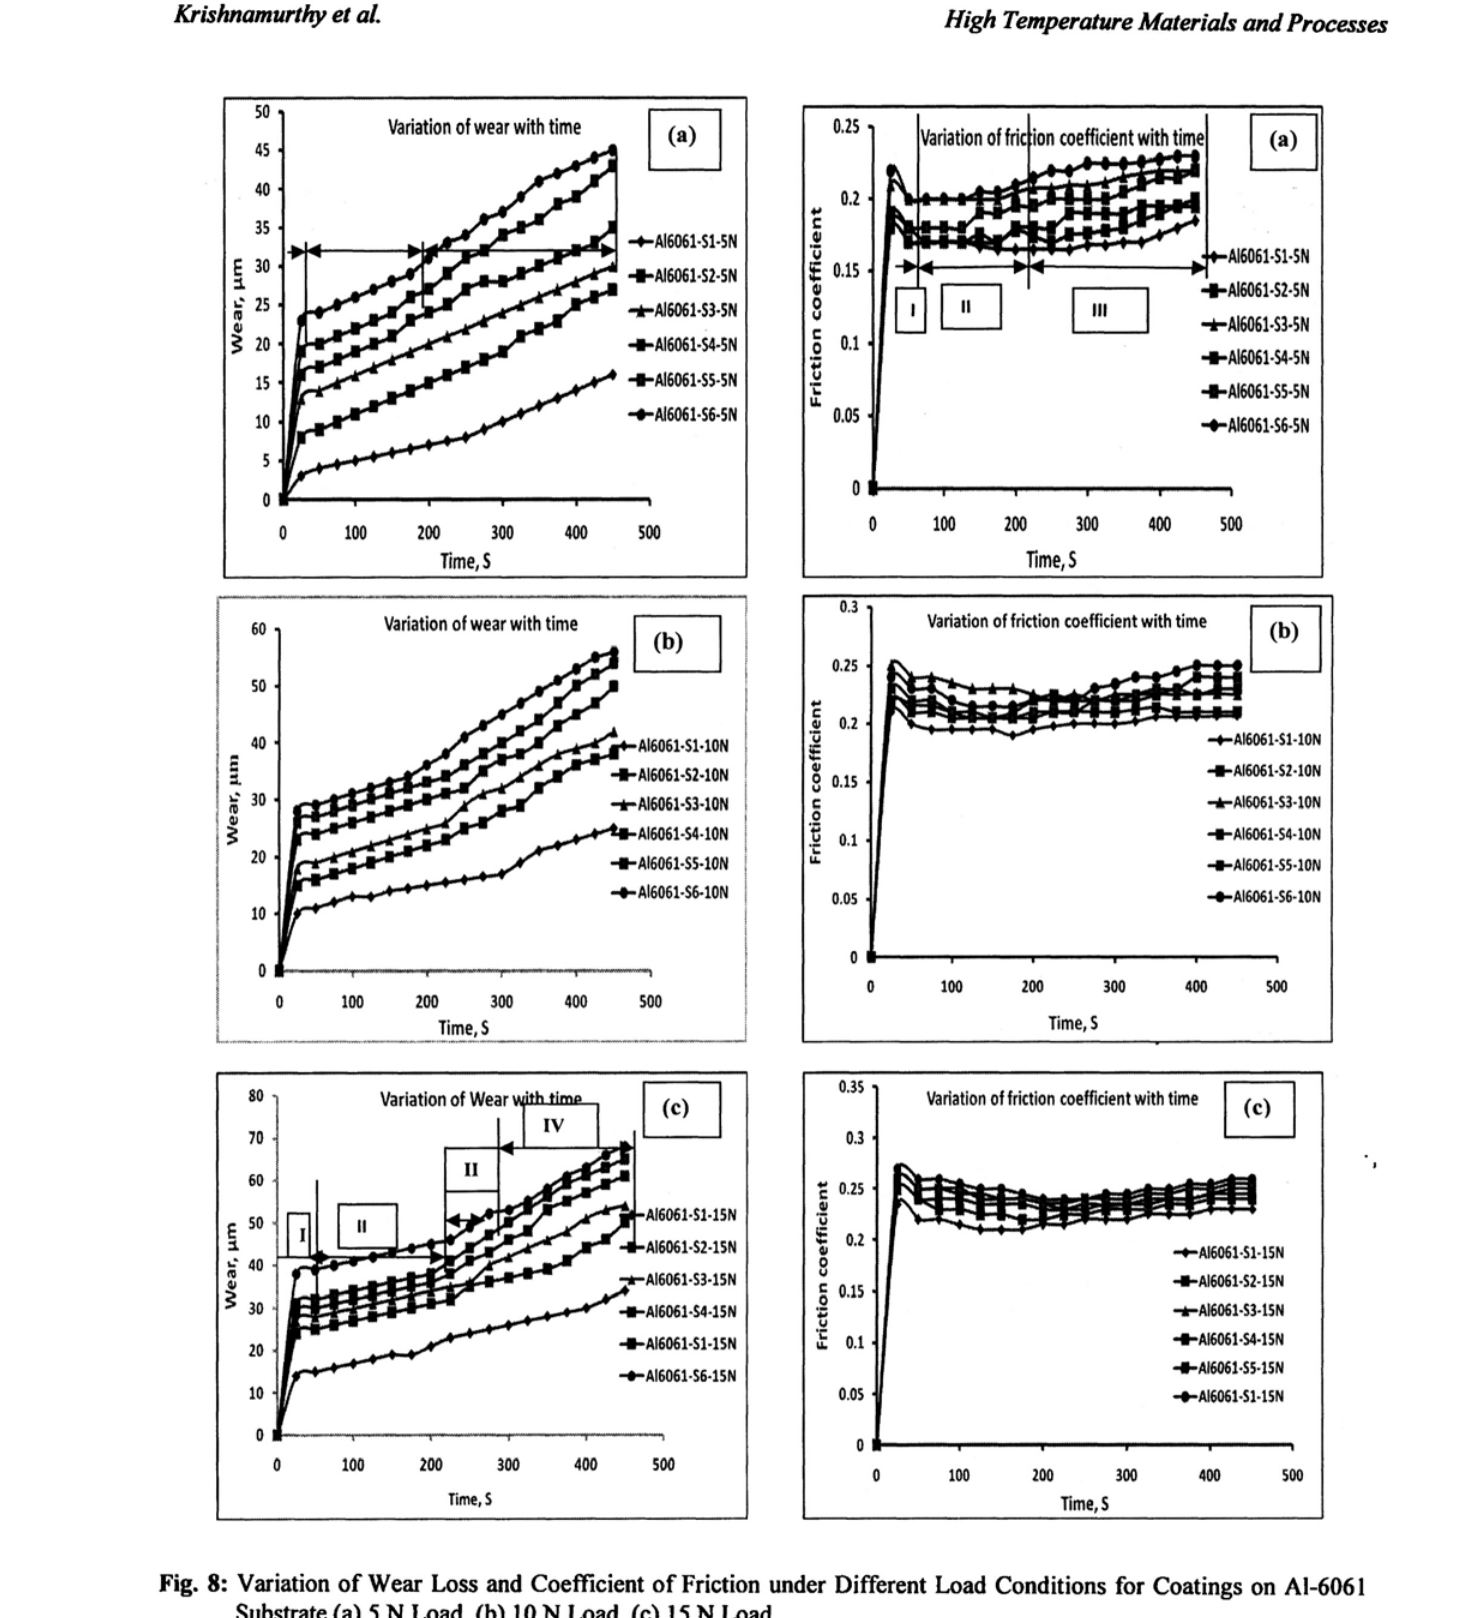
Fig. 8: Variation of Wear Loss and Coefficient of Friction under Different Load Conditions for Coatings on Al-6061 Substrate (a) 5 N Load (b) 10 N Load (c) 15 N